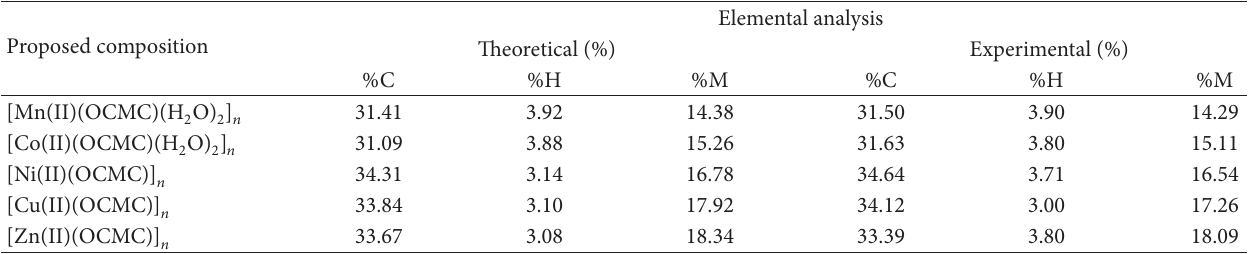
T 1: Elemental analysis of oxaloyl carboxymethyl cellulose (OCMC) and its Metallic Gel complexes.